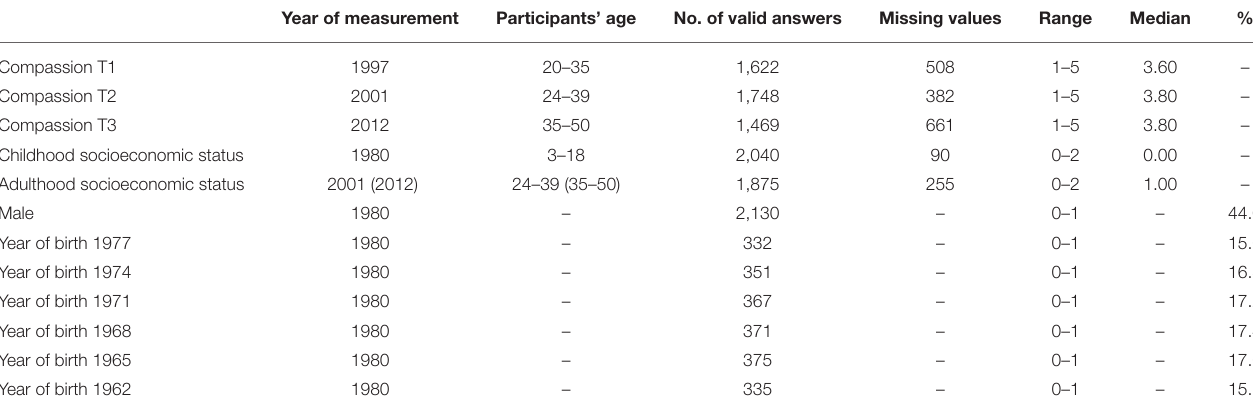
TABLE 1 | Descriptive statistics of the study variables. Year of measurement Participants’ age No. of valid answers Missing